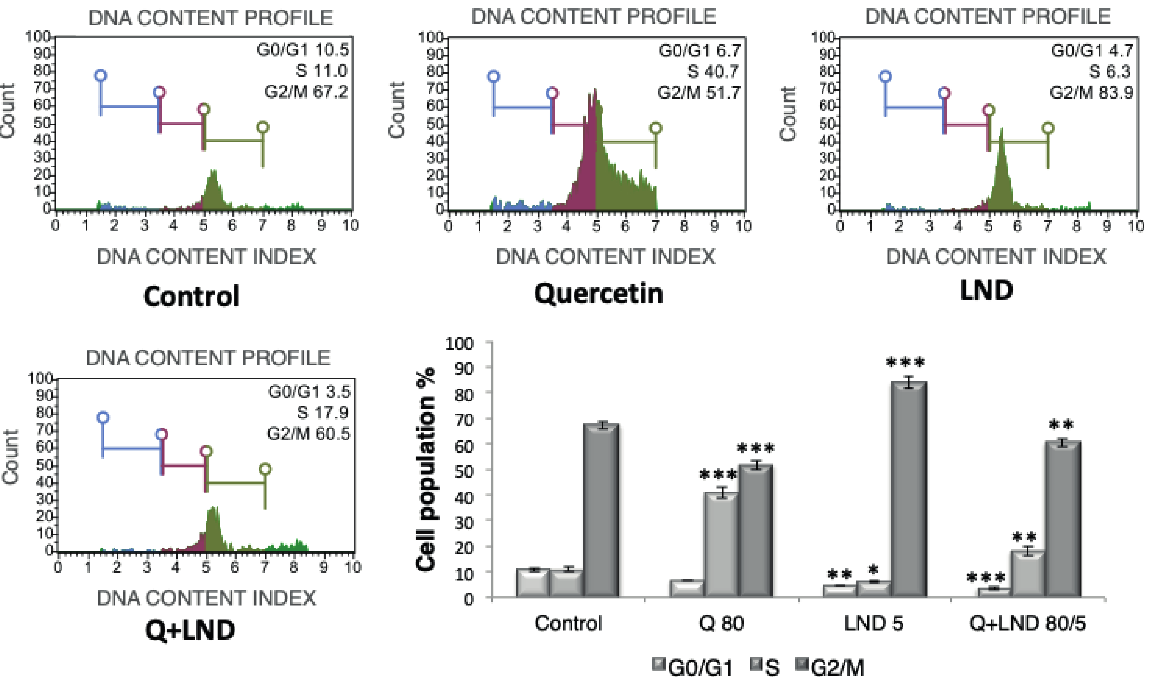
Figure 2. The results of cell cycle analysis. The MCF-7 cells were treated with 80 μM of quercetin, 5 μM of LND and 80/5 μM of Q+LND combination for 24 hr and the cell population percentage at different phases of cell cycle including G0/G1, S, and G2/M were detected by Muse Cell Analyzer (Millipore, Germany). The results were given for three independent